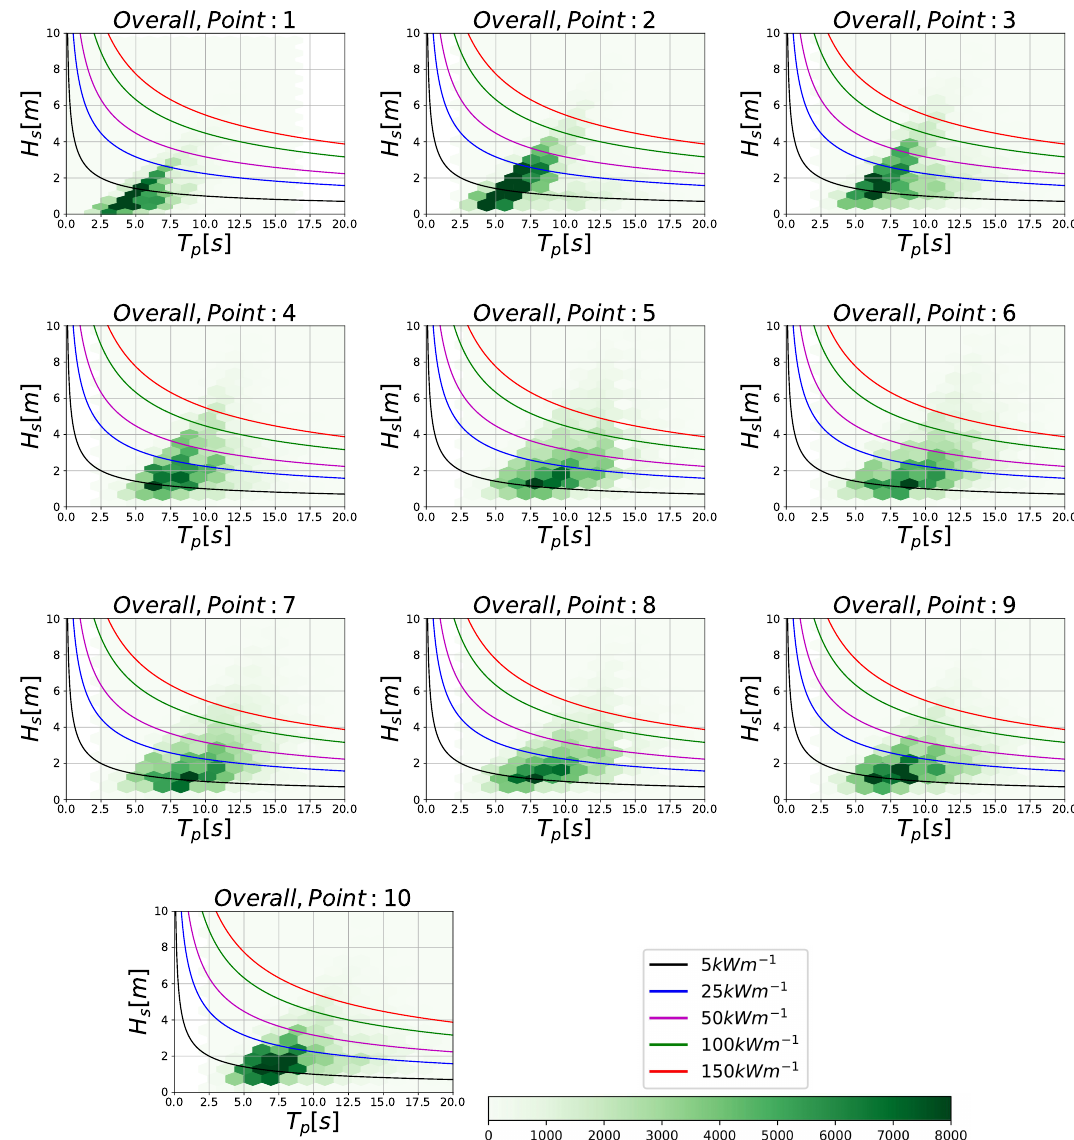
Figure 6. H s - T p diagram of peak wave period (s; x-axis) and total significant wave height (m; y-axis) during the 59-year period for Points 1–10. Colored areas and contours represent occurrence and WEF (kW m − 1 ),